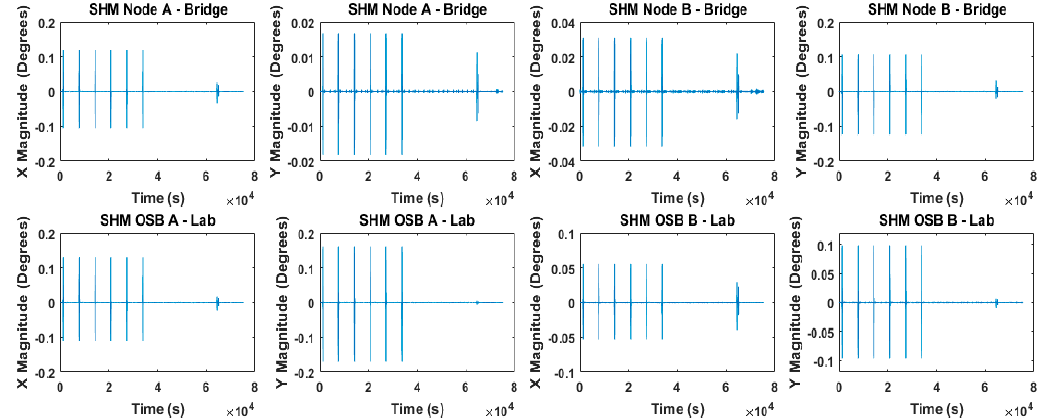
Figure 17. Bi-axial tilt angles data gathered at two unique geolocations in five calendar months (80,000 samples).